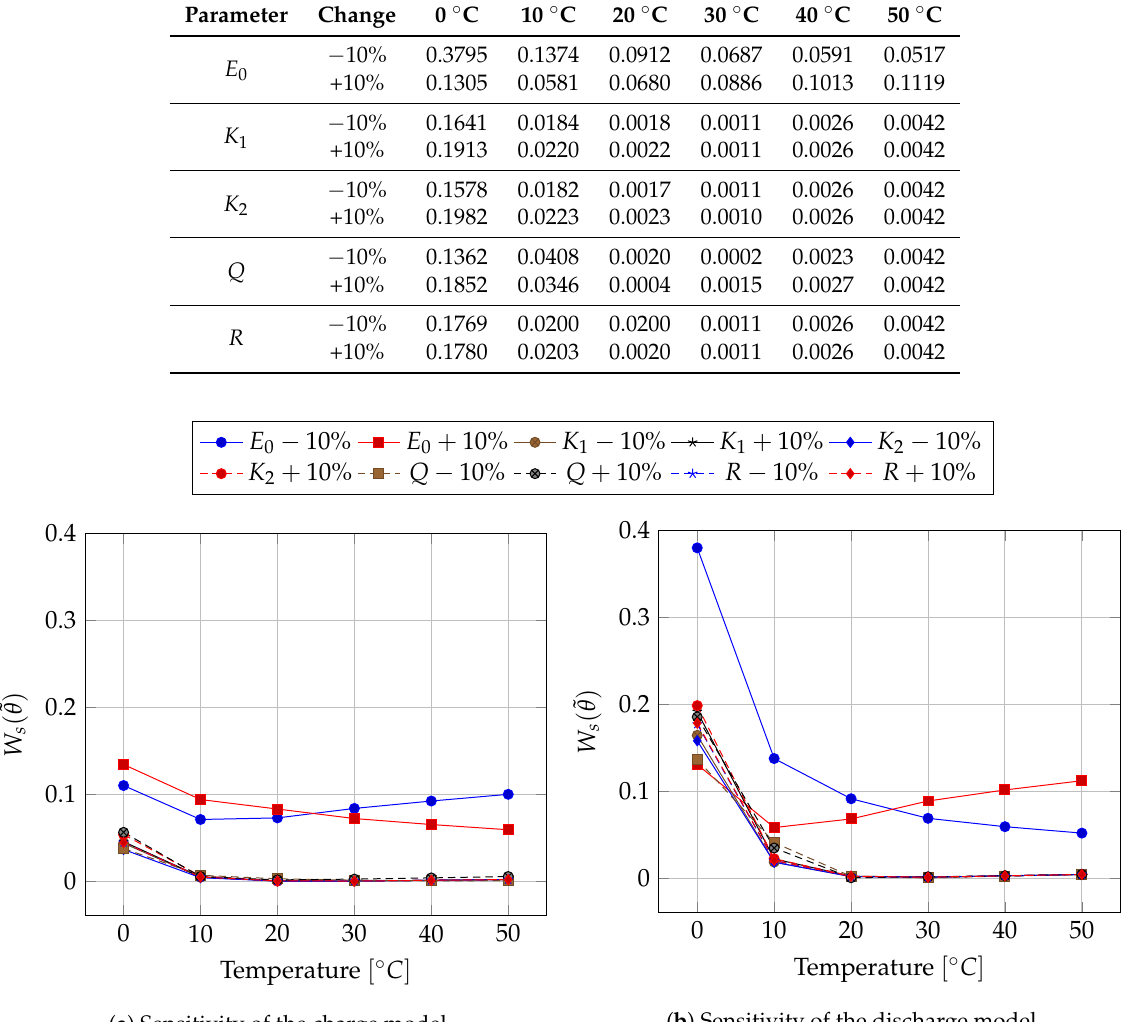
Table 3. Values of the loss function in case of the parameter sensitivity analysis of the discharge model.